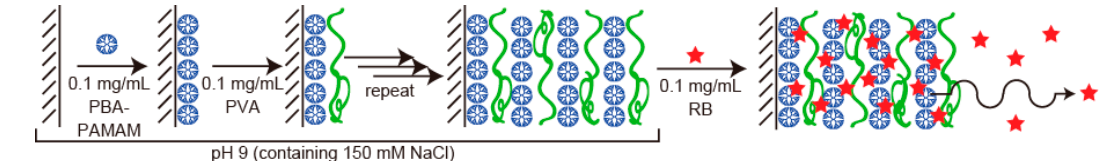
Figure 3. Schematic illustration of PBA-bearing- poly(amidoamine) (PBA-PAMAM)/poly(vinyl alcohol) (PVA) layer-by-layer (LbL) film preparation and rose bengal (RB) adsorption.